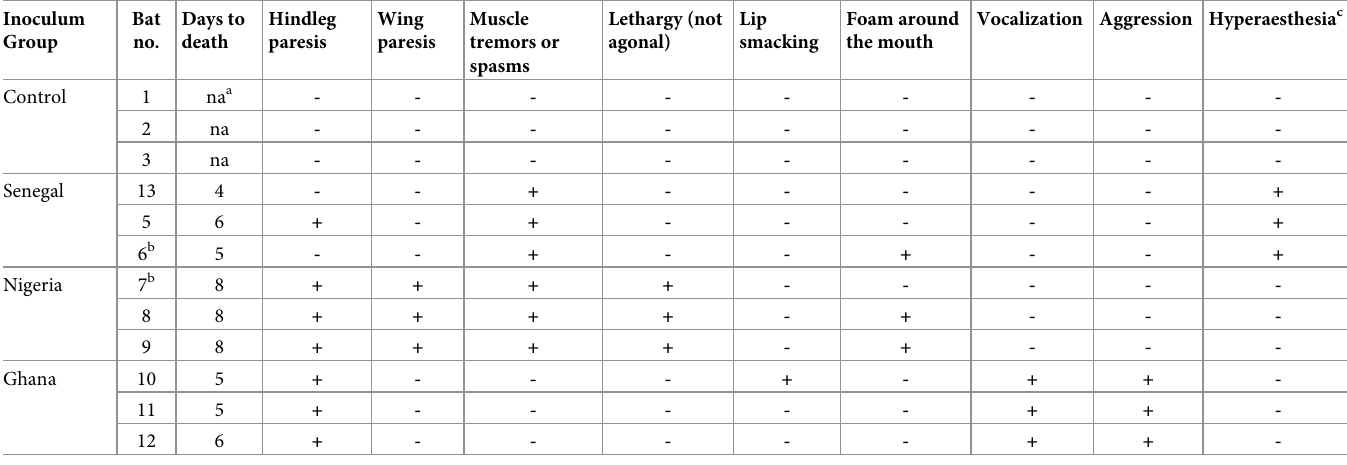
Vocalization Aggression Hyperaesthesia